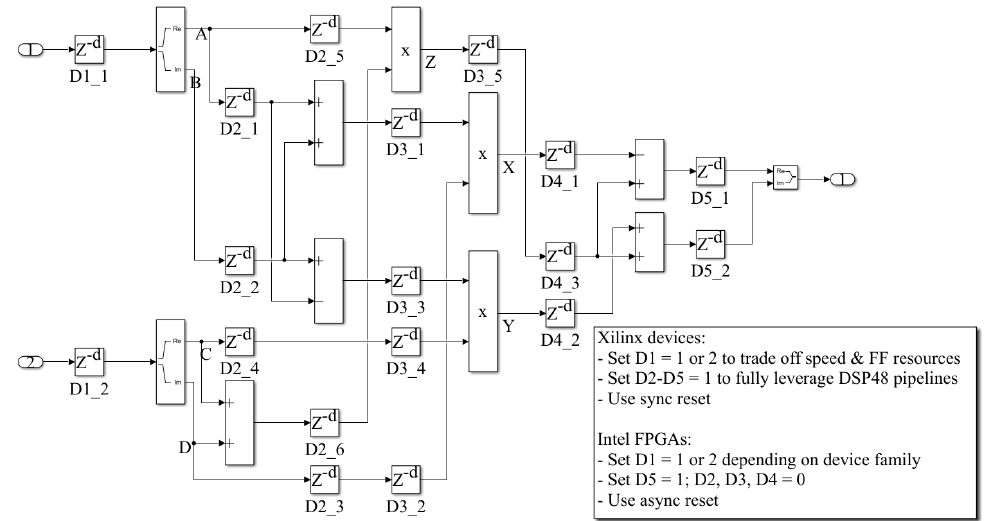
Figure 10. The hardware implementation of HDL complex multiplications of the QS-SVM optimiza- tion